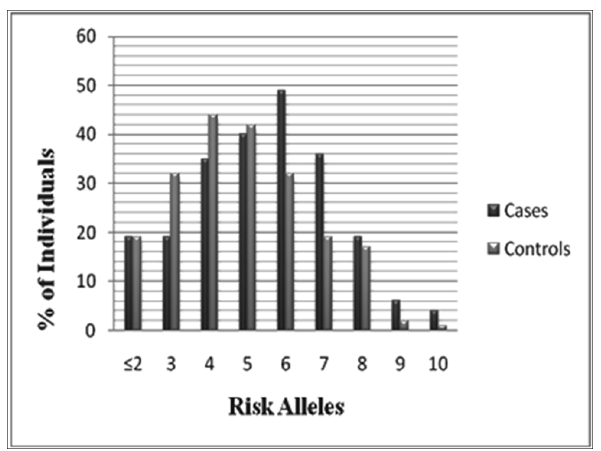
Figure 1. The 13-SNP G-score distribution in patients with gallstones and control subjects.